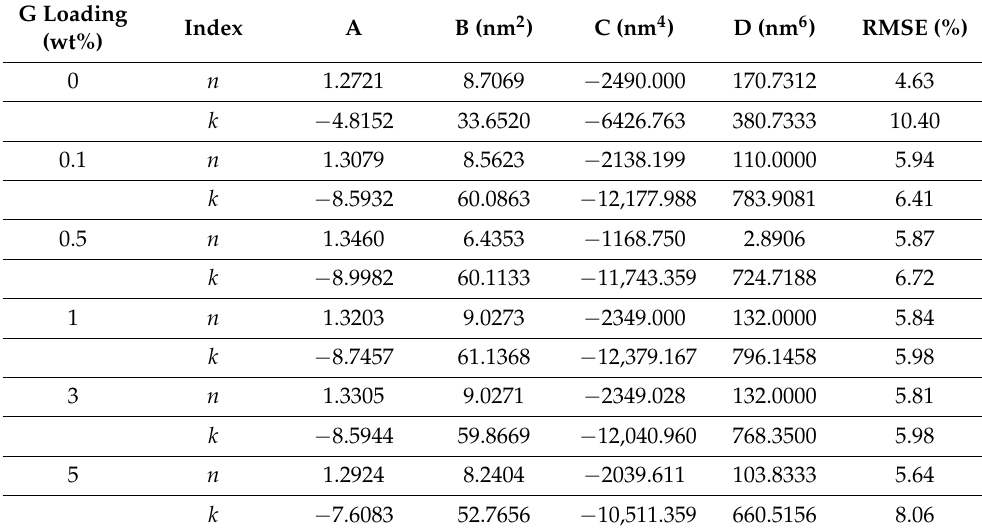
Figure 10. Refractive index ( a ) and extinction coefficient ( b ) fits to Cauchy’s equation for pristine P3HT. Experimental data are adapted from Ref. [9] with permission from the American Institute of Physics, 2012. Table 4. Optimal values of the fitting parameters to Cauchy’s equation for six different P3HT/G composites. The root mean square errors of the fits are also